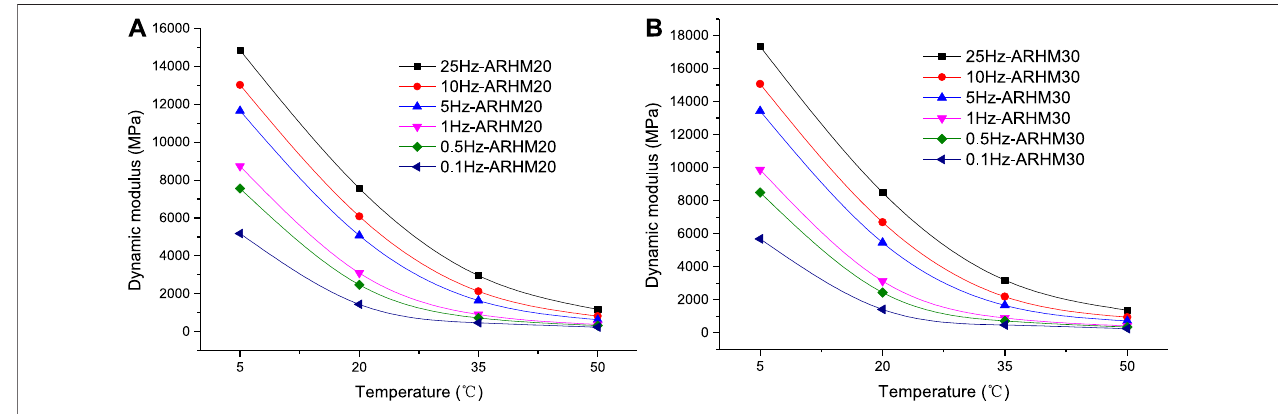
FIGURE 4 | Dynamic modulus of different types of rubber asphalt mixture.